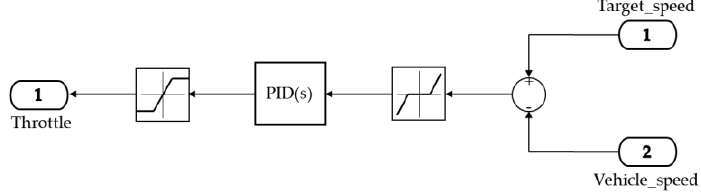
Figure 6. Throttle opening PID control